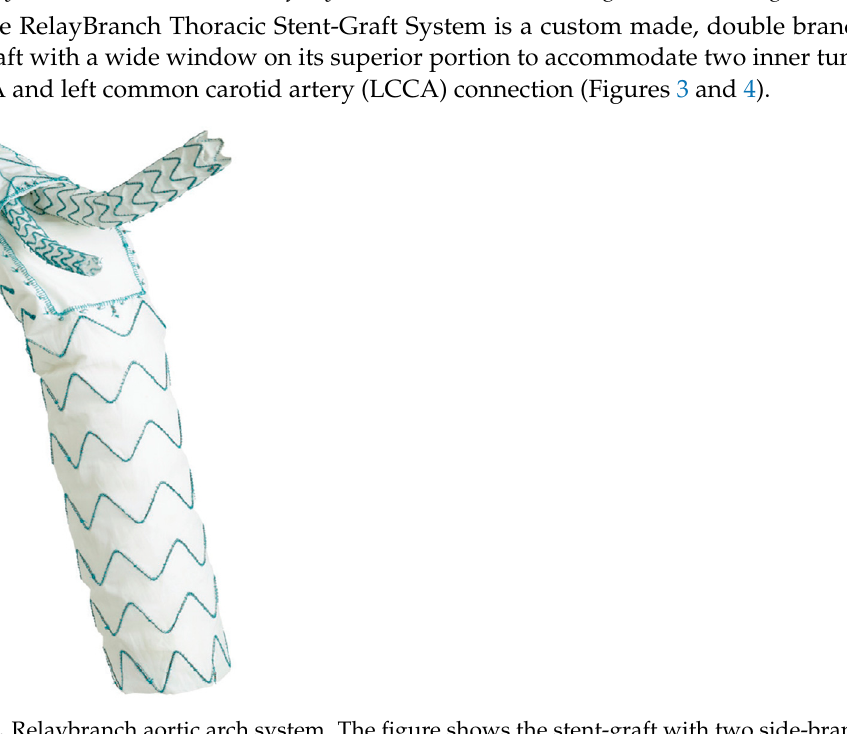
Figure 3. Relaybranch aortic arch system. The figure shows the stent-graft with two side-branches (for the brachio-cephalic trunk and for the left common carotid artery) that are positioned in the two tunnels of the upper window.